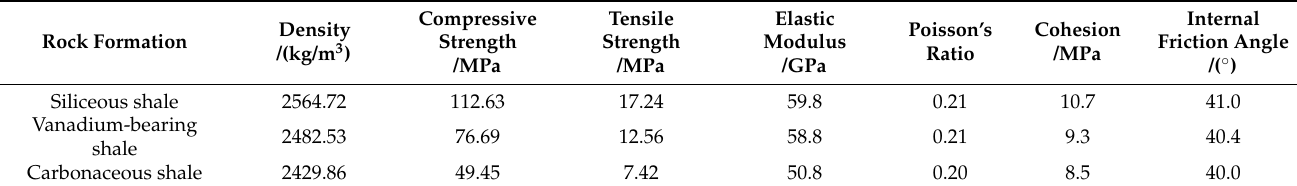
Table 3. Mechanics’ parameter of model